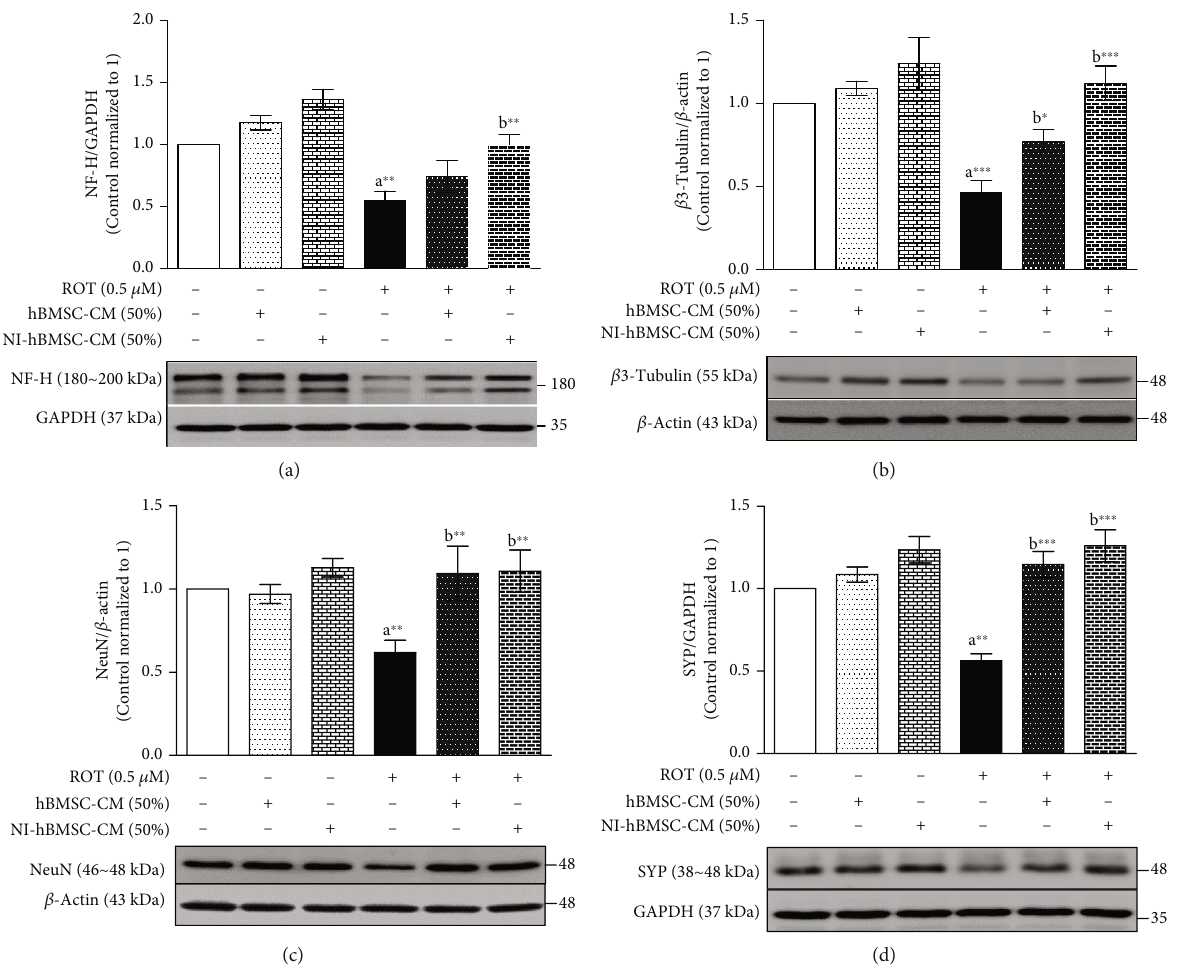
Figure 4: SH-SY5Y cells were seeded as 5 × 10 4 cells/mL of DMEM containing 1% FBS and used for experiments after overnight incubation. Cells with the absence or presence of ROT (0.5 μ M) for 48h were treated with hBMSC-CM (50%) or NI-hBMSC-CM (50%) during the last 24h and analyzed for NF-H (a), β 3-tubulin (b), NeuN (c), SYP (d), and GAPDH or β -actin by Western blotting. Each picture is representative of three independent experiments. Data are the mean ± SEM of three independent experiments and analyzed by one-way analysis of variance (ANOVA) followed by Tukey ’ s post hoc test. Statistical signi fi cance: a compared with control; b compared with ROT; ∗ p < 0 : 05 , ∗∗ p < 0 : 01 , and ∗∗∗ p < 0 : 001